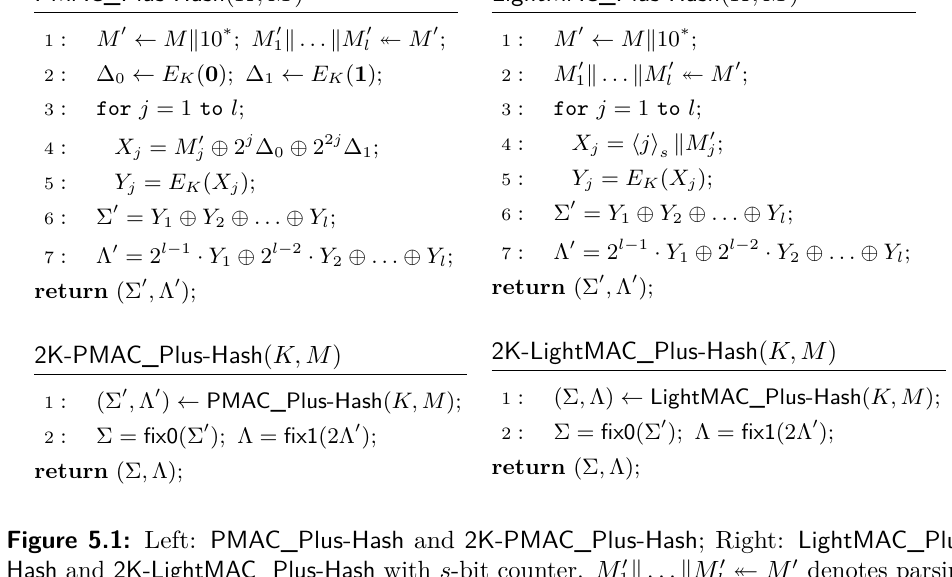
(cid:17) M 0 denotes k . . . k M 0 1 l